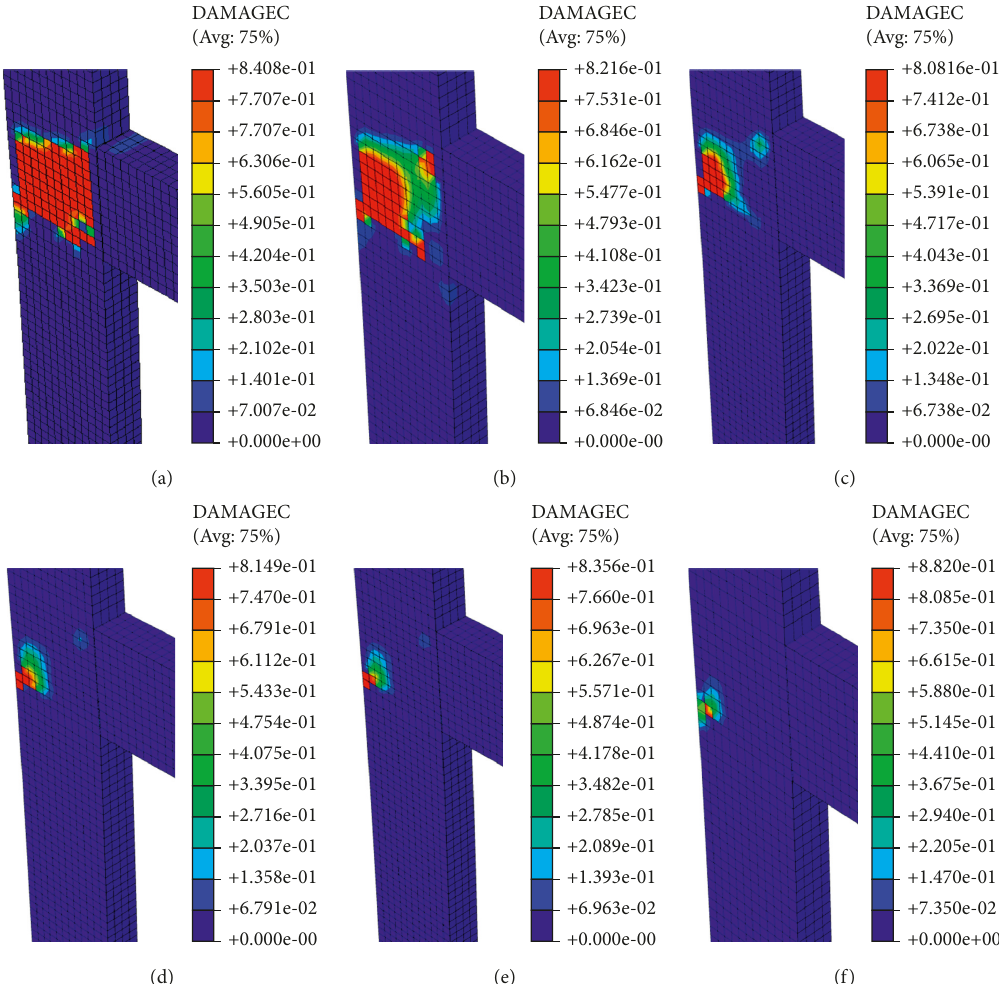
Figure 19: Concrete compression damage of specimens with various compressive strengths: (a) G2M1, 15MPa; (b) G2M2, 20 MPa; (c) Referential, 25MPa; (d) G2M3, 35MPa; (e) G2M4, 40 MPa; and (f) G2M5,